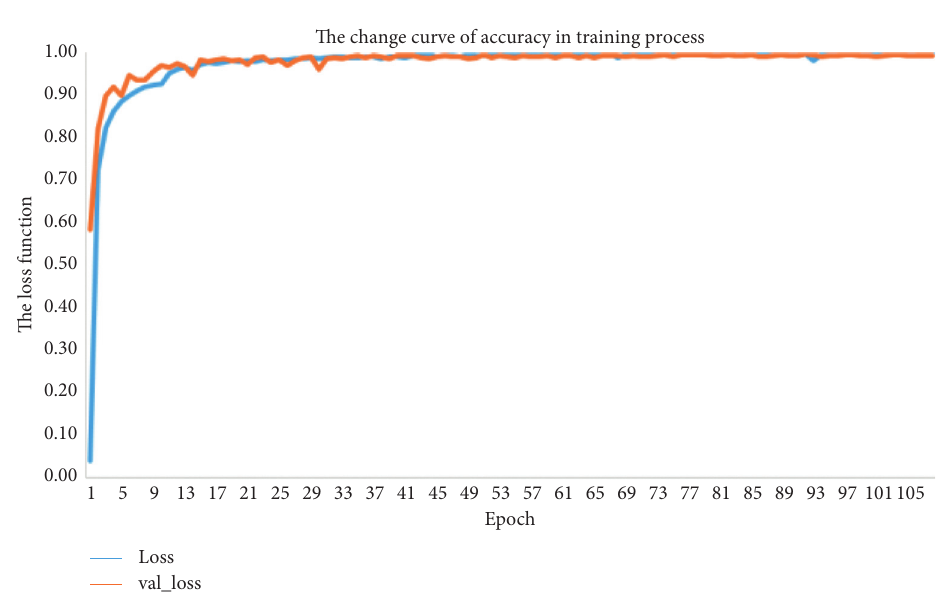
Figure 9: The accuracy of gearbox dataset